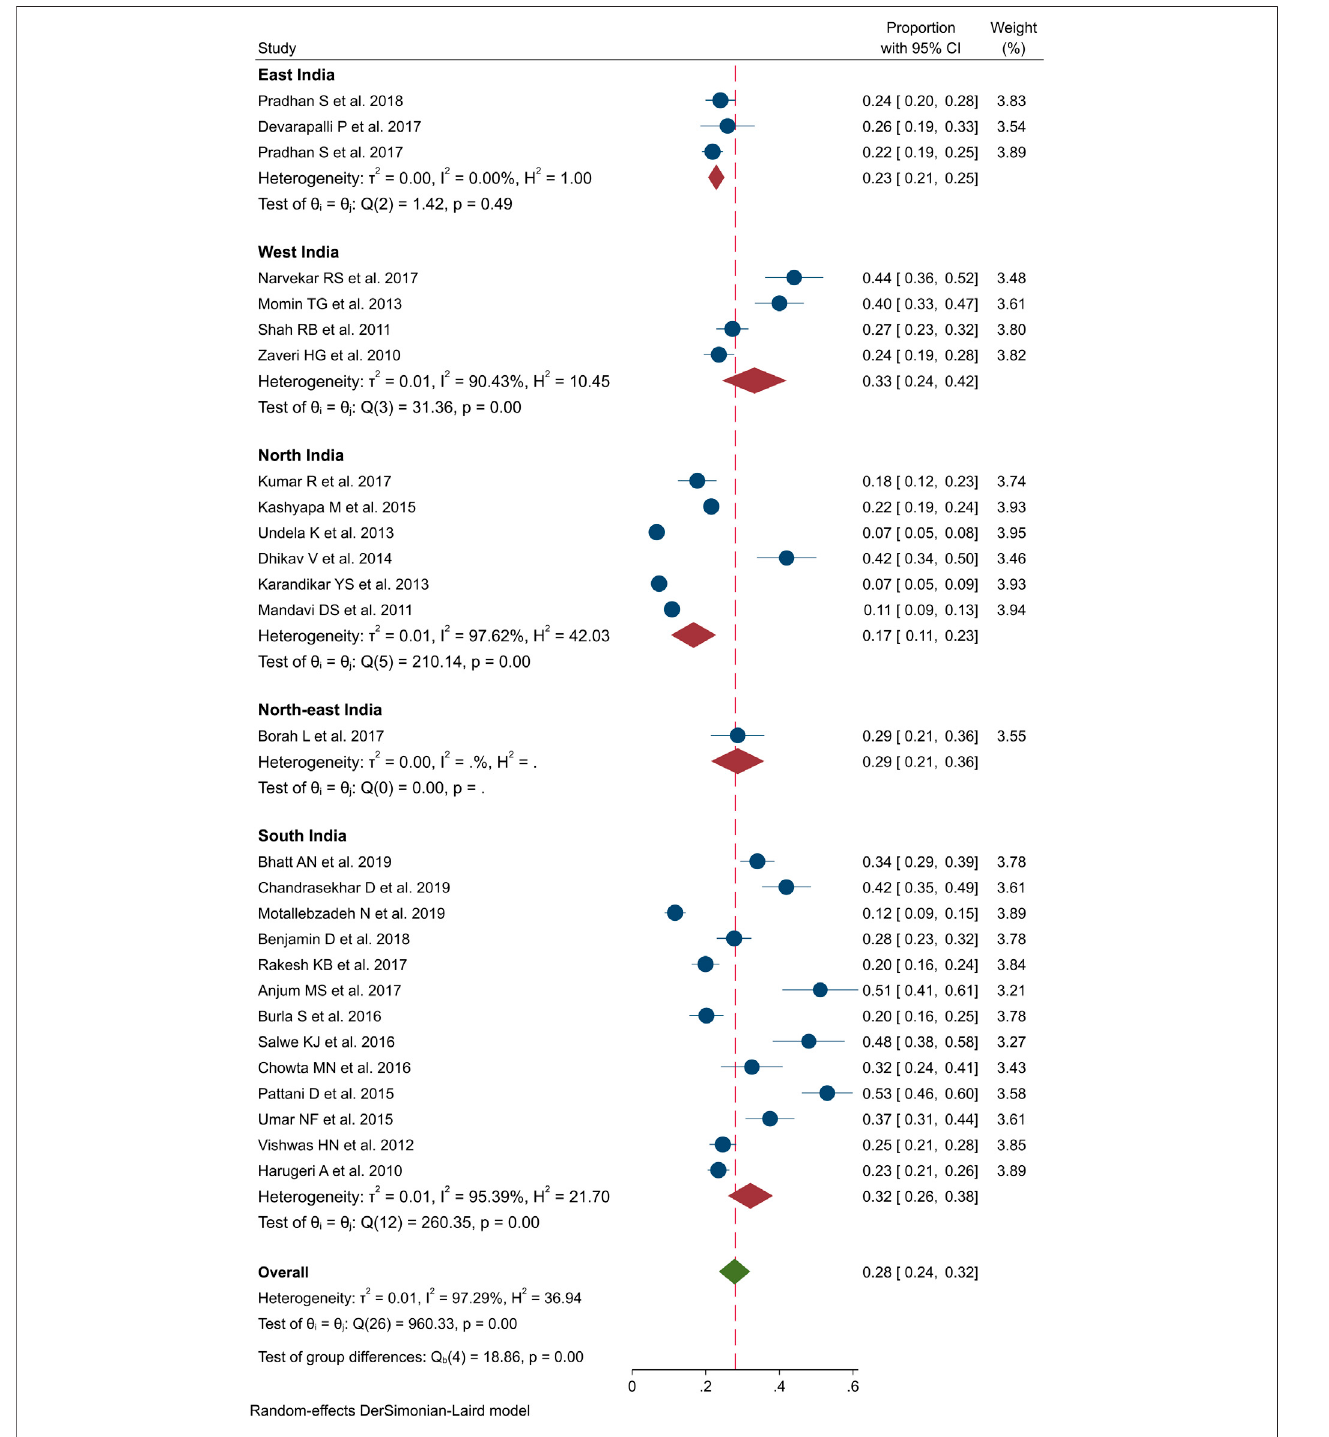
FIGURE 4 | Prevalence of potential inappropriate medication (PIM) use in older people across various geographic regions in India.